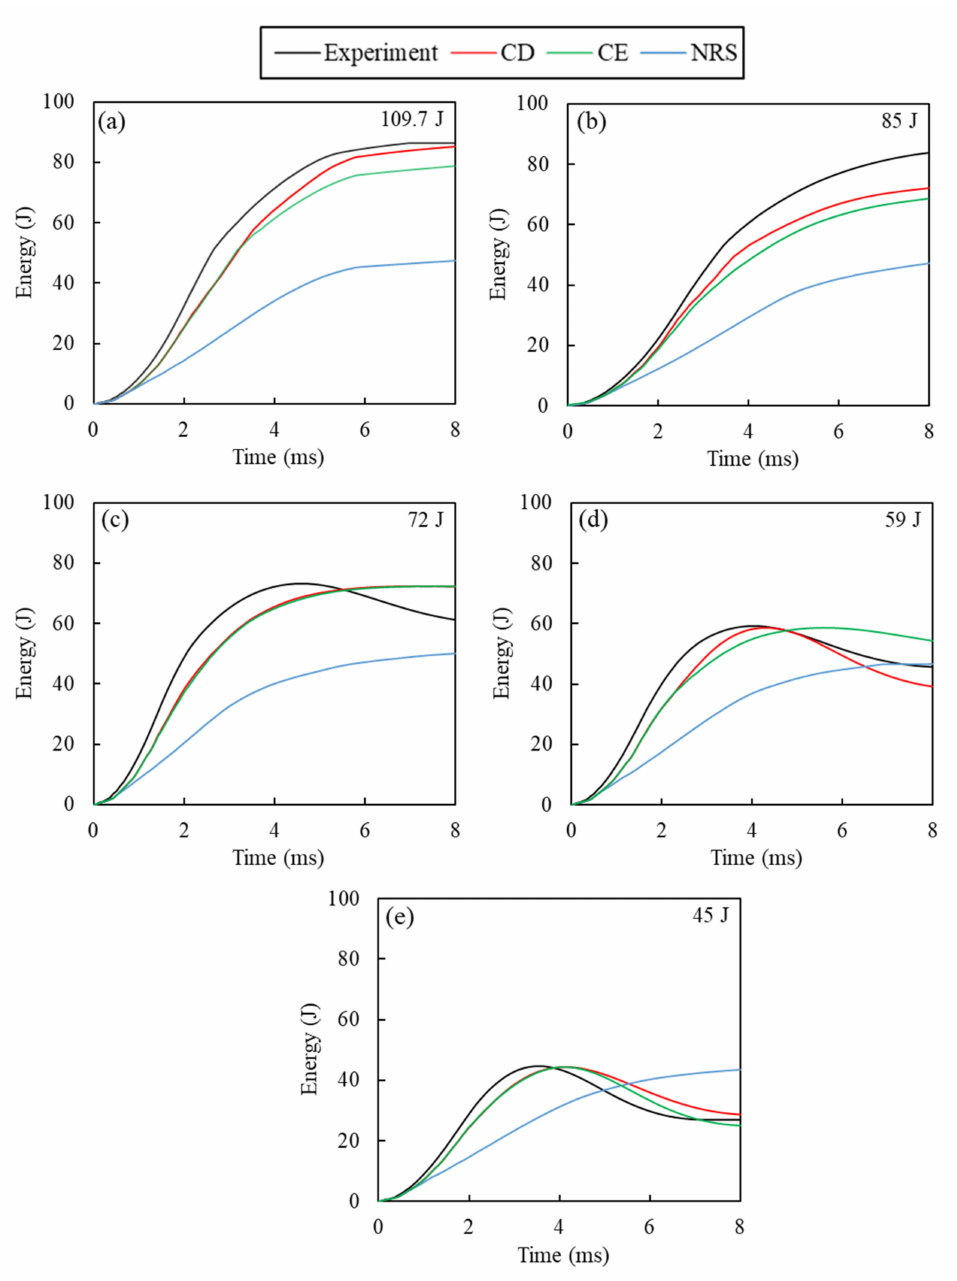
Figure 9. Comparison of numerical and experimental energy-time curves obtained for impact